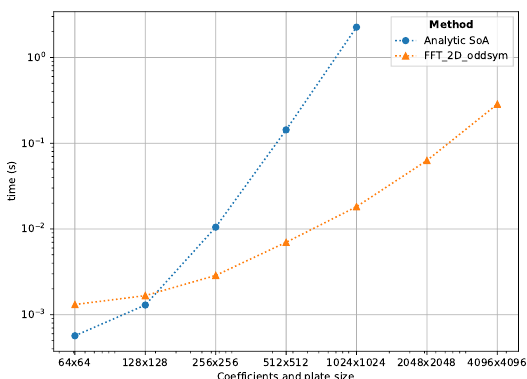
Figure 13. Appraisal of the computation times using an NVIDIA GeForce GTX960 (GPU) for the presented 2D odd symmetric FFT method vs the brute-force method presented in Reference [25]